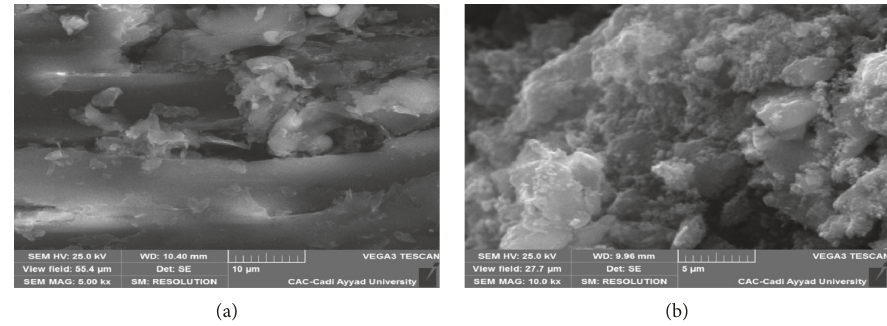
Figure 2: SEM of (a) raw prickly pear seed cake and (b) optimal activated